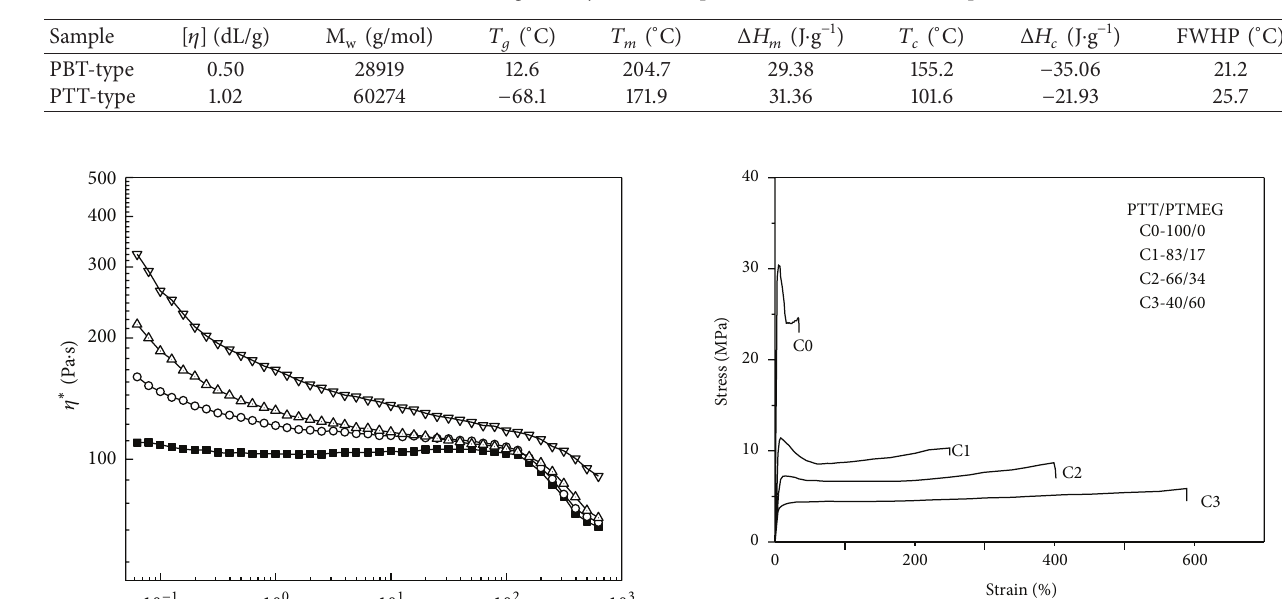
Table 5: DSC melting and crystallization parameters of the various samples.